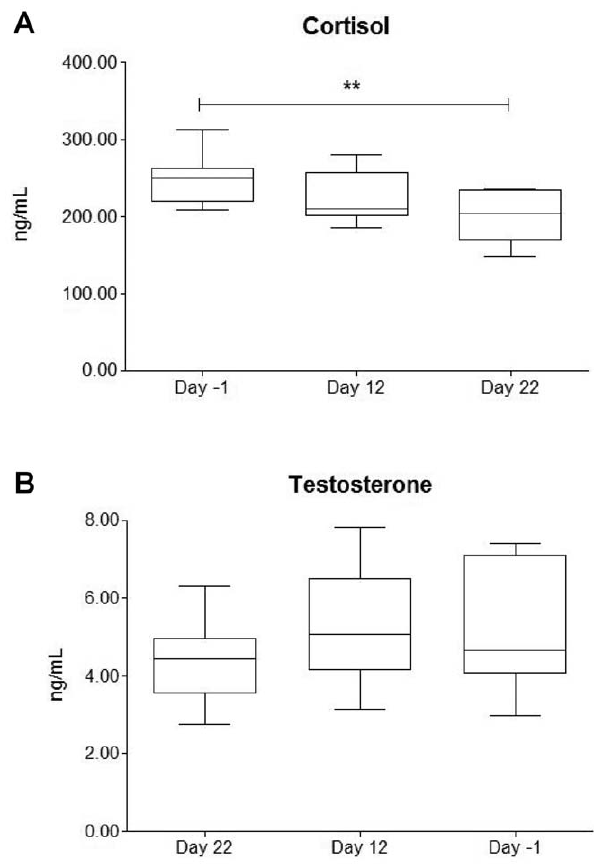
Figure 4. Modification of cortisol and testosterone concentra- tions over the race. The Figure shows the trends of serum cortisol (panel A) and serum testosterone (panel B) over the stage race. ** indicates a significant variation (p , 0.01).